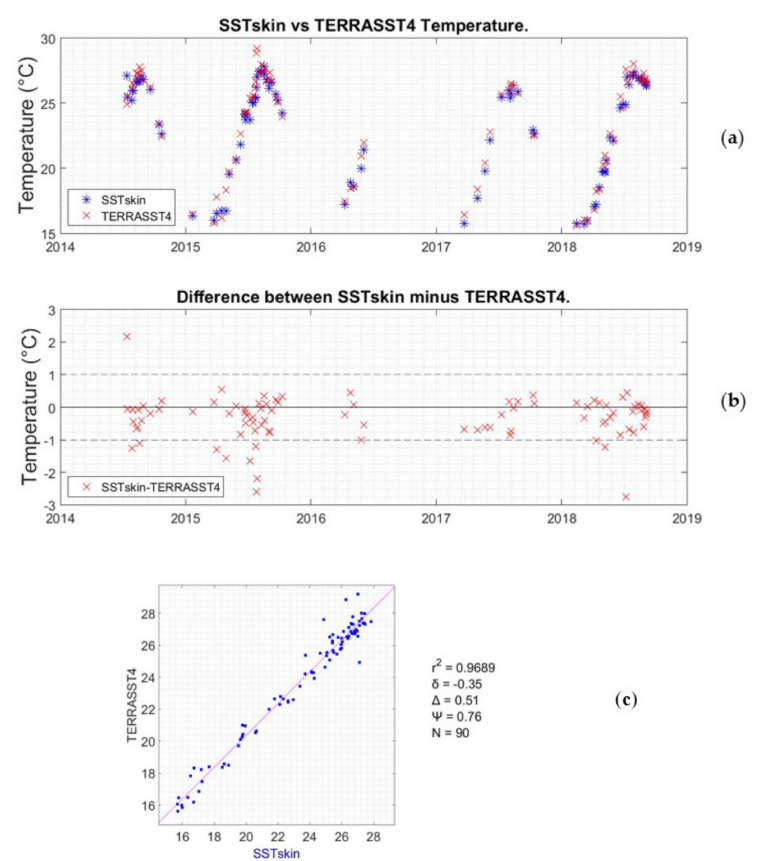
Figure 7. ( a ) SSTskin extracted and averaged data within ± 1 h of the respective satellite overpass compared with Terra MODIS data from the cell that contains the Seafloor Observatory from TERRASST4 dataset. ( b ) Di ff erence between the SSTskin minus the TERRASST4 dataset. ( c ) Correlation plot between the SSTskin and the TERRASST4 dataset (refer to Section 2.4 for definitions). Table 2. Comparison statistics between the MODIS AQUA and MODIS TERRA datasets and the SSTskindata. The SSTskin data are averaged from within +/ − 1 h of the AQUA and TERRA satellite overpass. The squared Pearson correlation coe ffi cient (r 2 ), the mean bias ( δ ), the mean absolute error ( ∆ ), the root mean squared error ( Ψ ), and the number of matchups taken into account are presented. r 2 δ ∆ Ψ